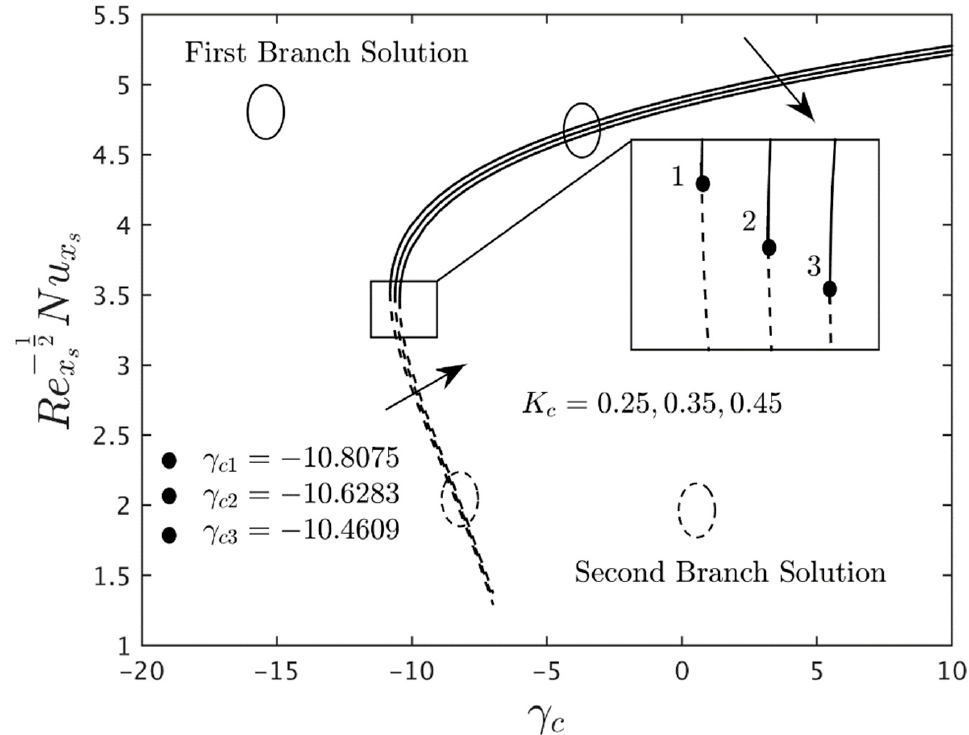
for the several values of c